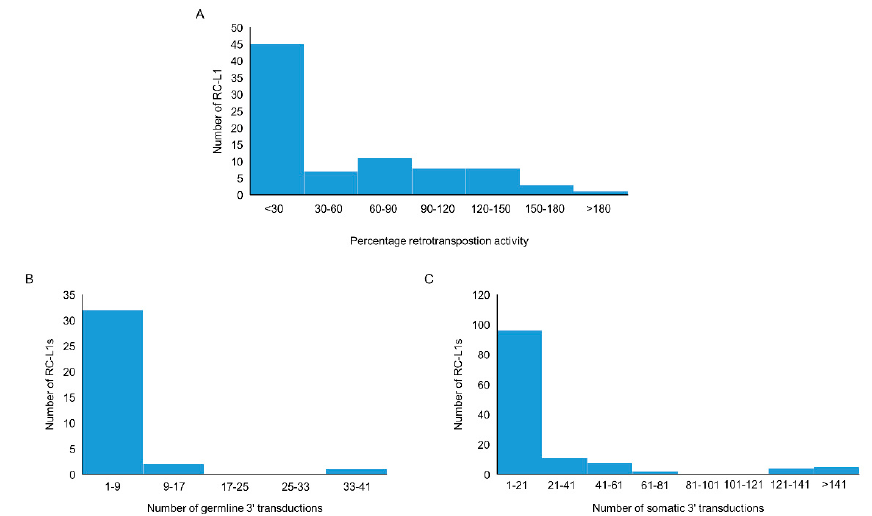
Figure 2. Characteristics of reference and non-reference retrotransposition competent (RC) L1s. ( A )